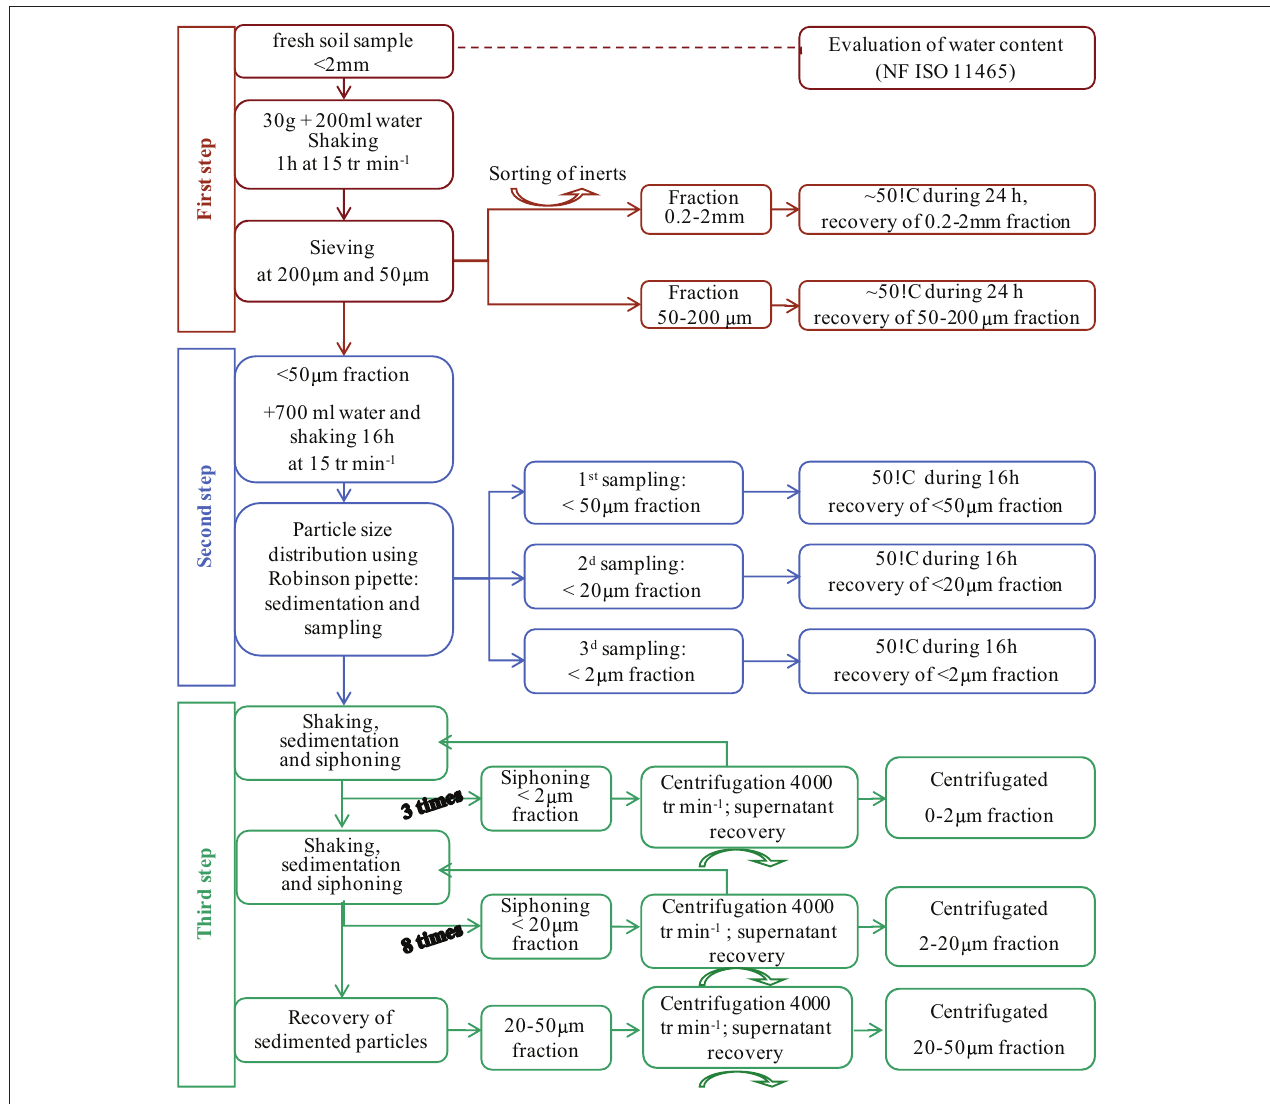
FIGURE 1 | Soil fractionation scheme for the recovery of granulometric fractions and MPs in the solutions of the washing steps.